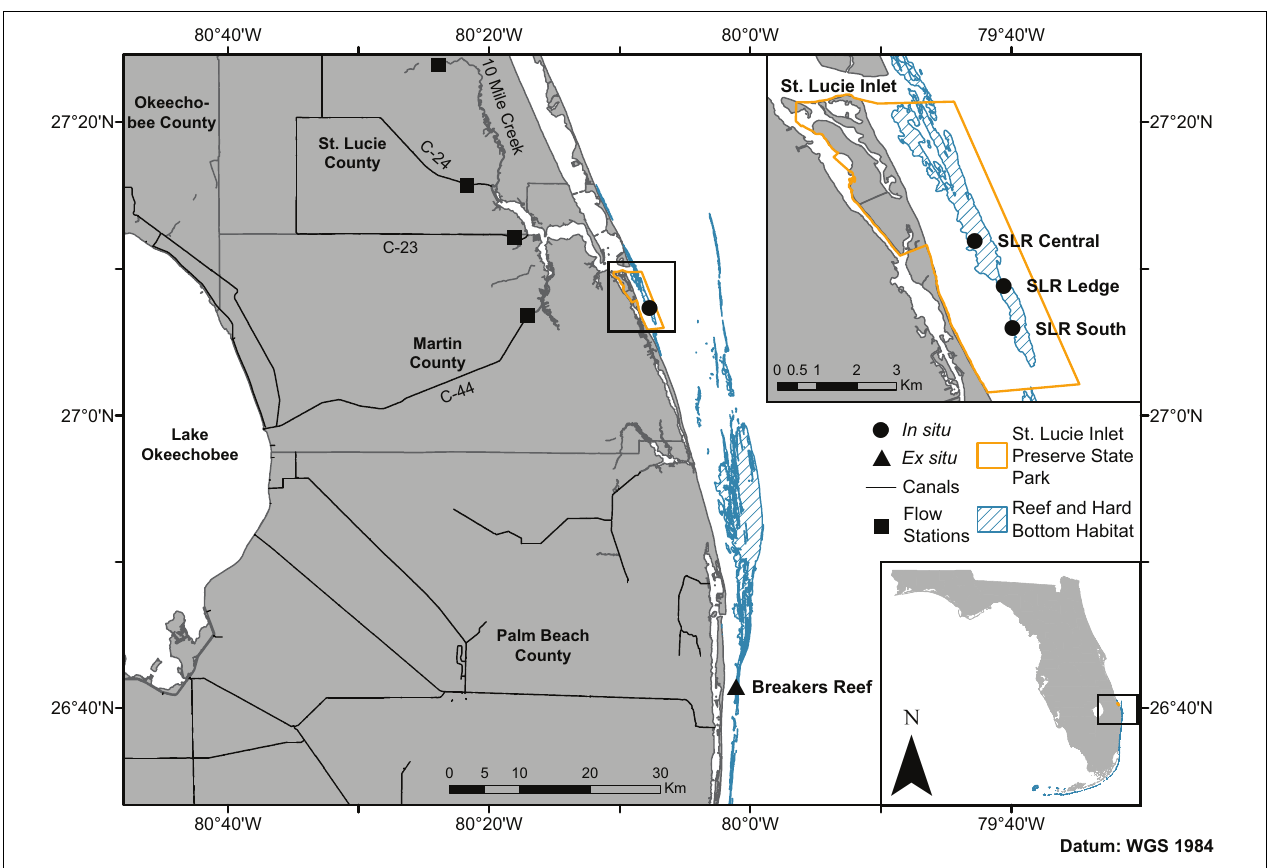
FIGURE 1 | Map of the northern extent of Florida’s coral reef tract including the sampling sites in the in situ experiment (circles: SLR Central, SLR Ledge, and SLR South) and coral collection site for the ex situ experiment (triangle: Breakers Reef). Squares represent canal control structures where discharge flow rates and rainfall (C-44 only) data were obtained from the South Florida Water Management District’s DBHYDRO database. State park shapefile sourced from the Florida Department of Environmental Protection’s Division of Recreation and Parks, reef and hard bottom habitat shapefile sourced from the Florida Fish and Wildlife Conservation Commission-Fish and Wildlife Research Institute, canal shapefile sourced from the South Florida Water Management